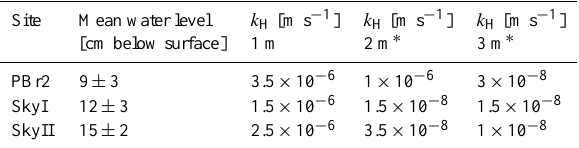
Fig. 2. Concentrations of Rubidium (solid squares), Strontium (solid triangles) and Zirconium (crosses) in the peat samples in parts per million. Clearly identified volcanic tephra layers are highlighted in gray. Less well defined tephra layers and underlying sediment in the SkyI record are highlighted by a lighter gray. The thick gray bands in the PBr2 and SkyII records indicate the deposit of the Mt. Burney eruption 4250 yr BP.